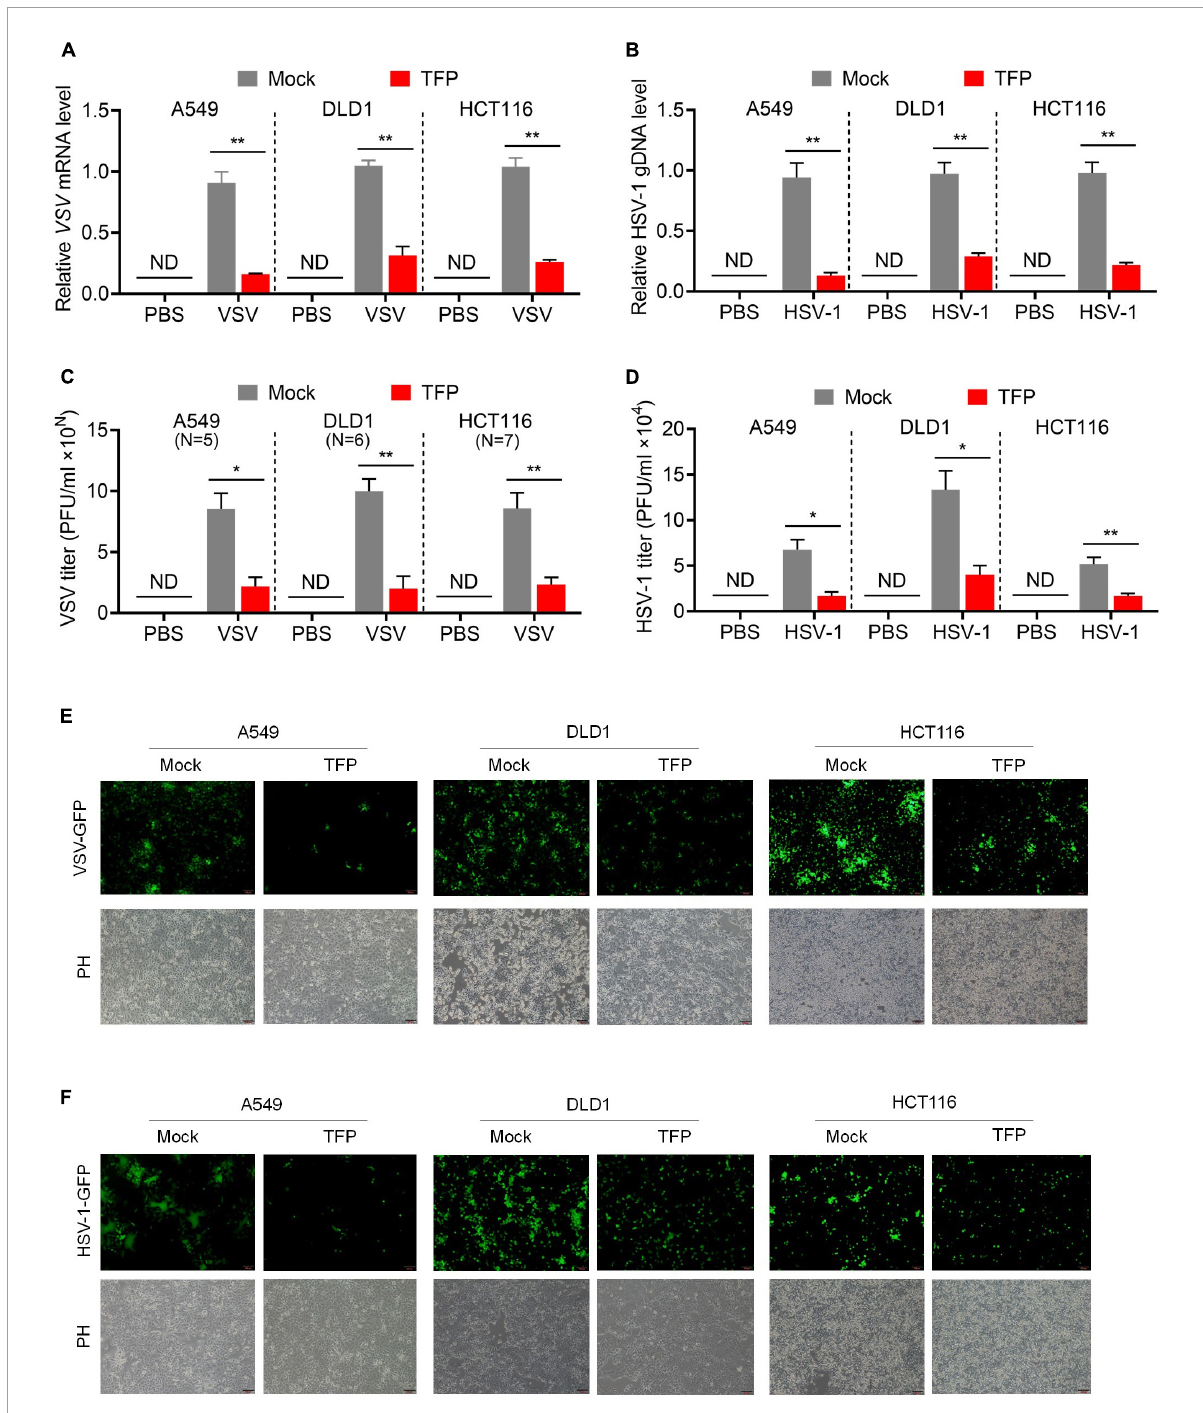
FIGURE2 TFP inhibits VSV and HSV-1 replication. (A,B) qPCR analysis of VSV mRNA expression (A) and HSV-1 gDNA expression (B) in mock or TFP-treated A549, DLD1, and HCT116 cells. Cells were infected with VSV-GFP (MOI = 0.1) for 12 h or HSV-1 (MOI = 10) for 24 h after 12 h of 15 µ M TFP treatment. (C,D) Plaque assay of VSV titers (C) and HSV-1 titers (D) in mock or TFP-treated A549, DLD1, and HCT116 cells shown in panels (A,B) . The “10 N ” of the Y-axis in panel (C) means the magnitude of VSV titer of A549, DLD1, and HCT116 cells are 10 5 , 10 6 , and 10 7 , respectively. (E,F) Images of green fluorescence change under a fluorescence microscope in mock or TFP-treated A549, DLD1, and HCT116 cells shown in panels (A,B) . Scale bars, 100 µ m. ND, not detected. * p < 0.05, ** p < 0.01 (two-tailed Student’s t -test). Data from three independent experiments [means ± SDs of triplicate assays (A–D) ] or representative data from three independent experiments with similar results (E,F) are